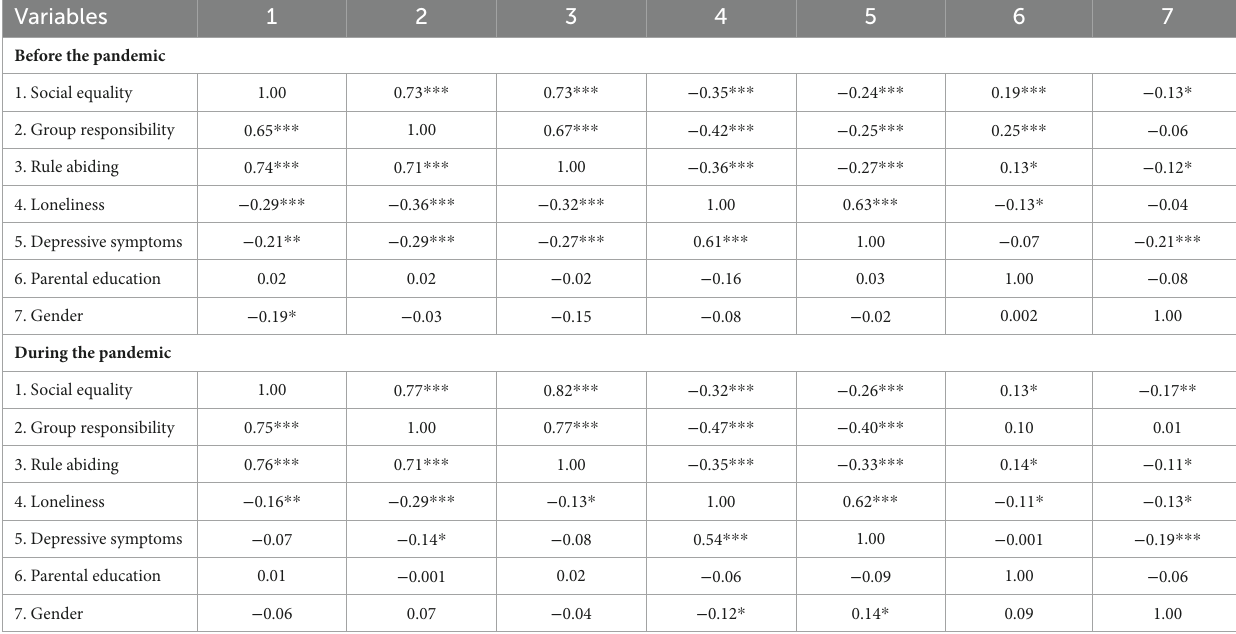
TABLE 4 Correlations of study variables in urban and rural groups before and during the pandemic.